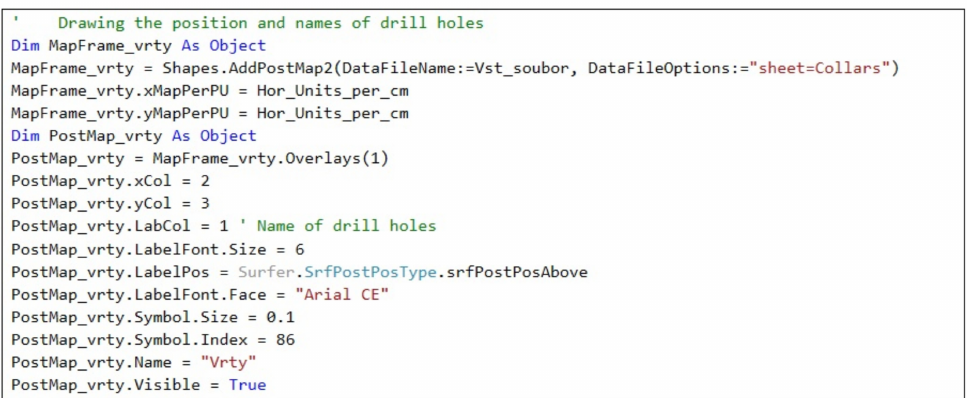
Figure 23. Code sample using the Surfer object